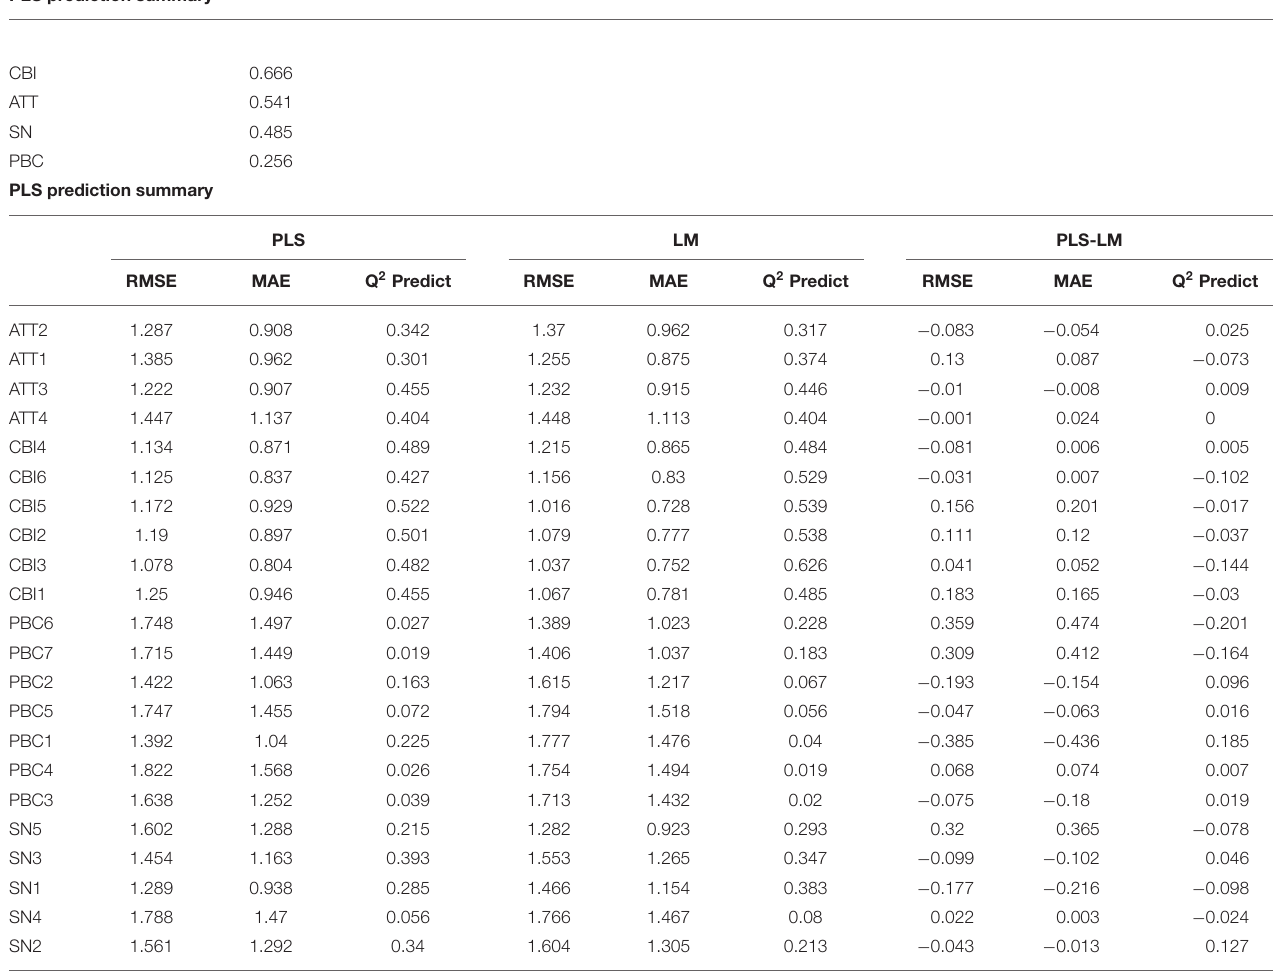
TABLE 6 | PLS predict